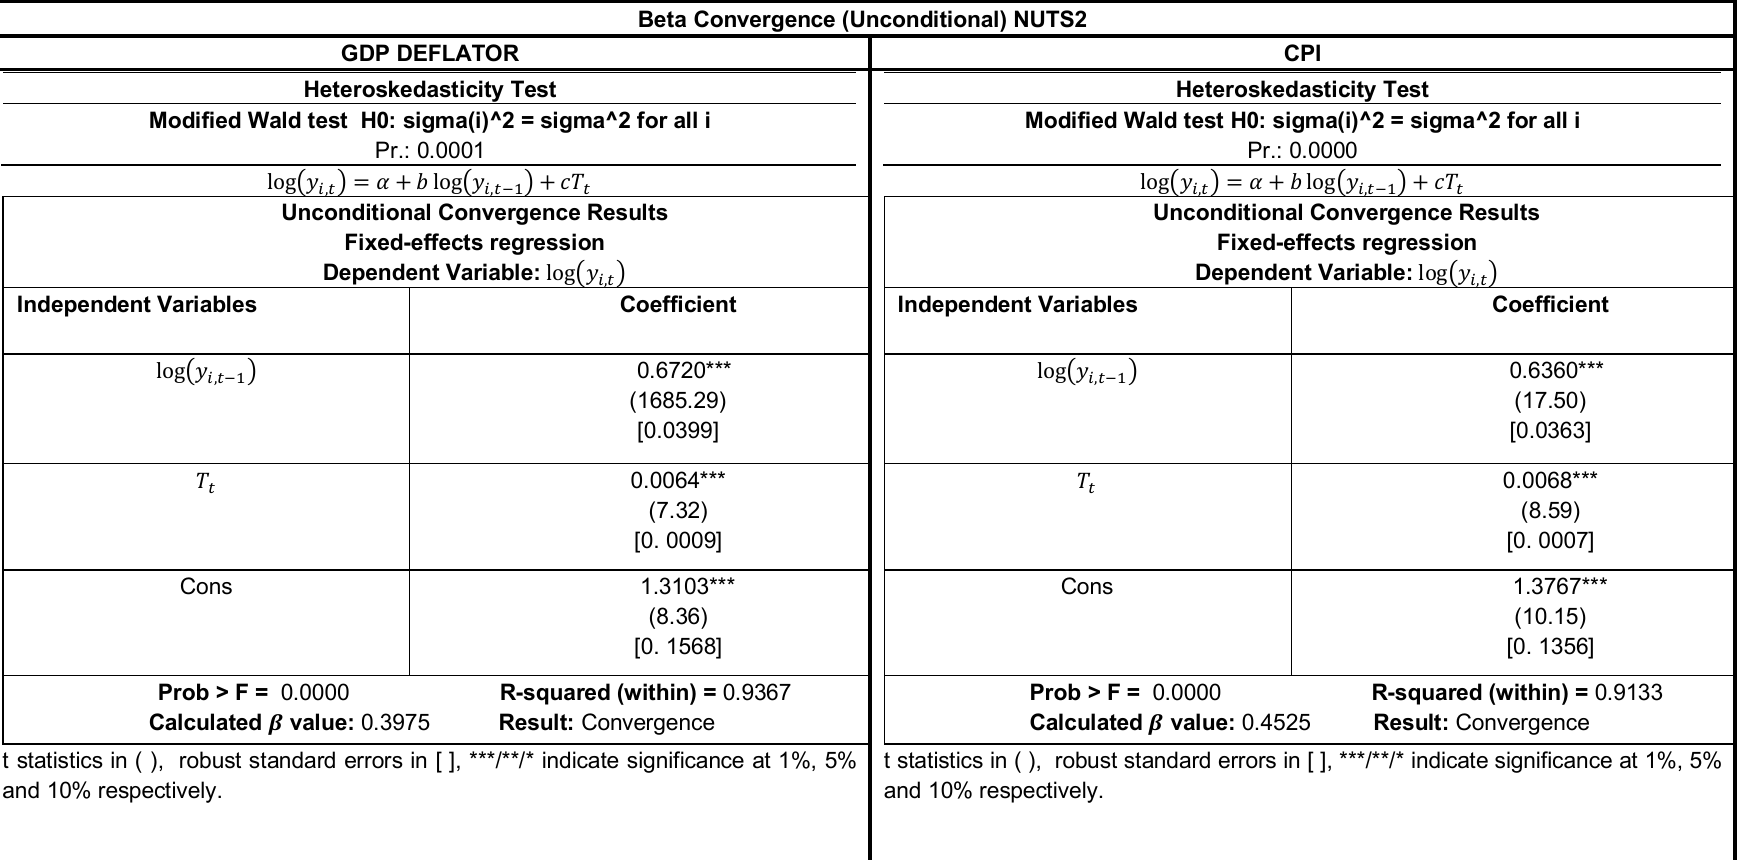
Table A.1: Comparison between GDP Deflator and CPI (2005-2017)